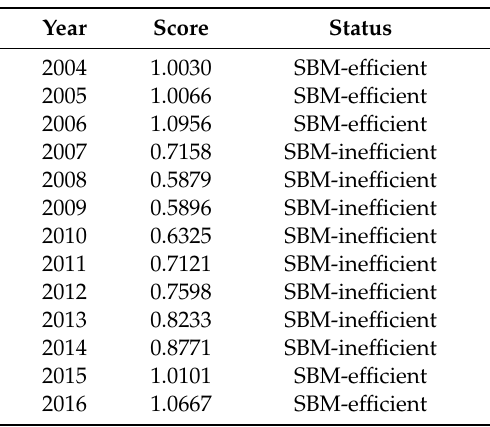
Table 3. Mariculture e ffi ciency scores of China, 2004–2016.